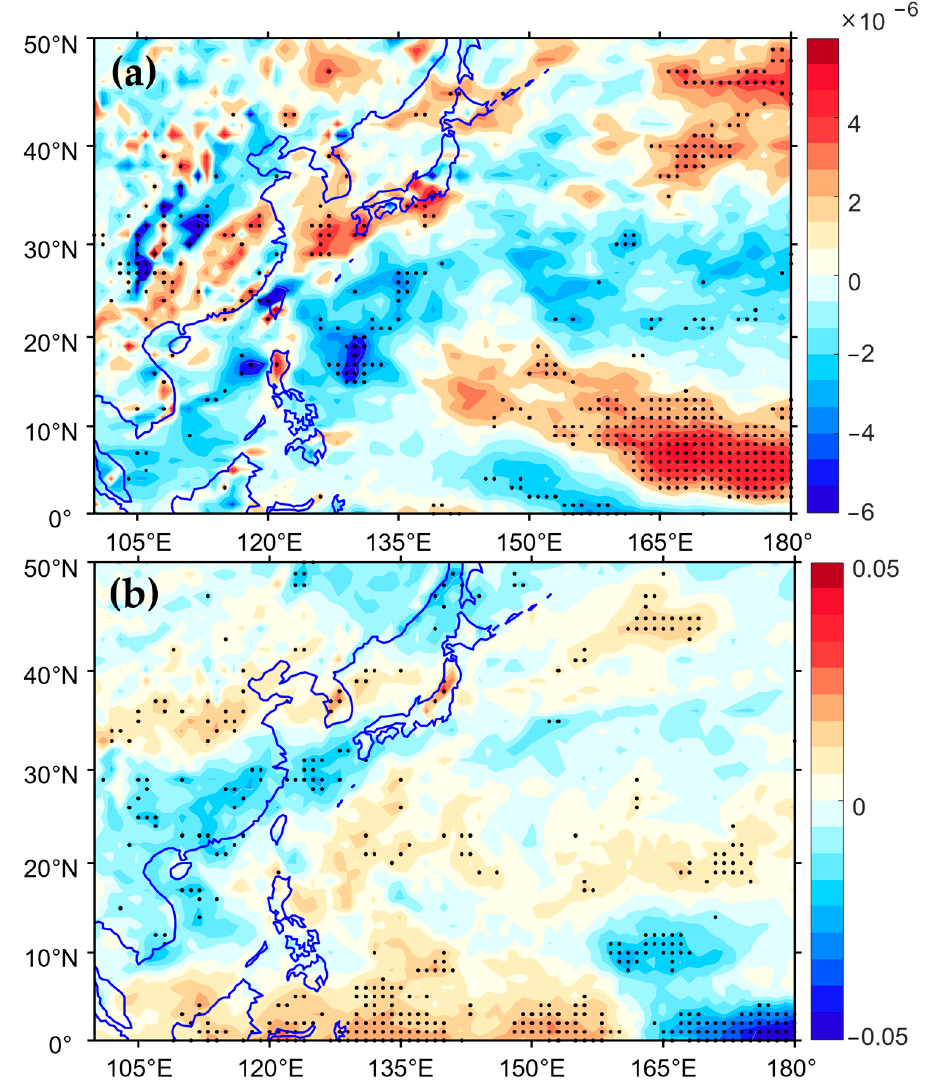
Figure 7. The differences (SP minus SU) in the ( a ) relative vorticity at 850 hPa (unit: 10 − 6 s − 1 ), and ( b ) vertical velocity at 500 hPa (unit: Pa · s − 1 ) during the typhoon season of SP and SU El Niño years. The dots mark the areas that were statistically significant at the 95% confidence level.